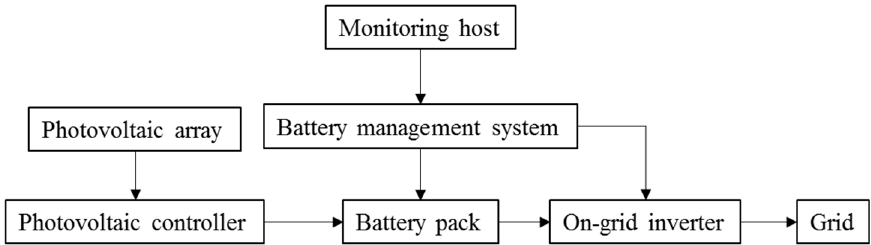
Figure 3. Schematic view of an on-grid system and key components.